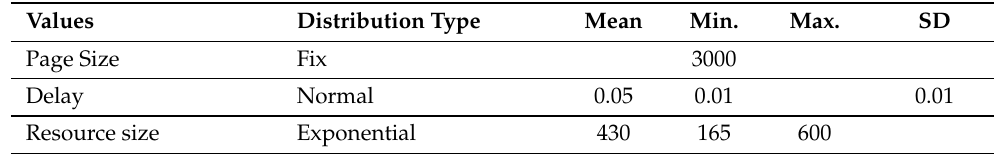
Table 4. Middleware configuration